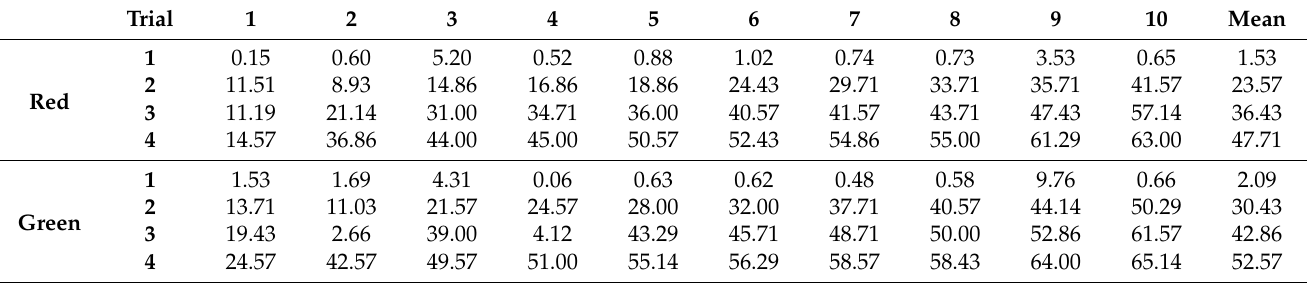
Table A2. Dynamic time warping non-linear (elastic) alignment distance results for all trial histograms delineated by color channel using day-0 control images specific to each trial. The table heading denotes the day of treatment that was compared to the day-0 control for each individual trial. The side of the table denotes trial number as detailed in Table 1. Values are represented as percentage DTW difference relative to a 7 × 10 6 -pixel